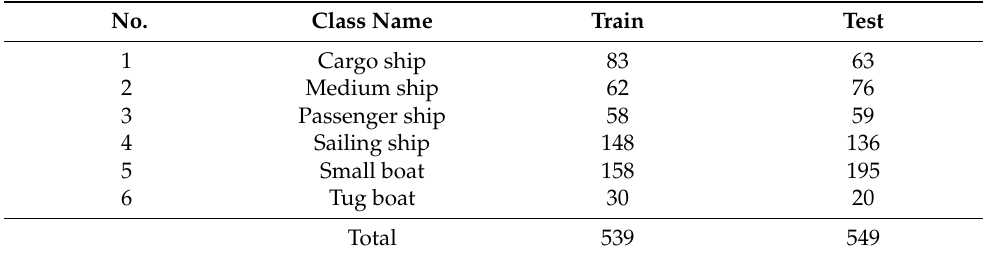
Table 1. Number of training and testing samples in VAIS dataset.